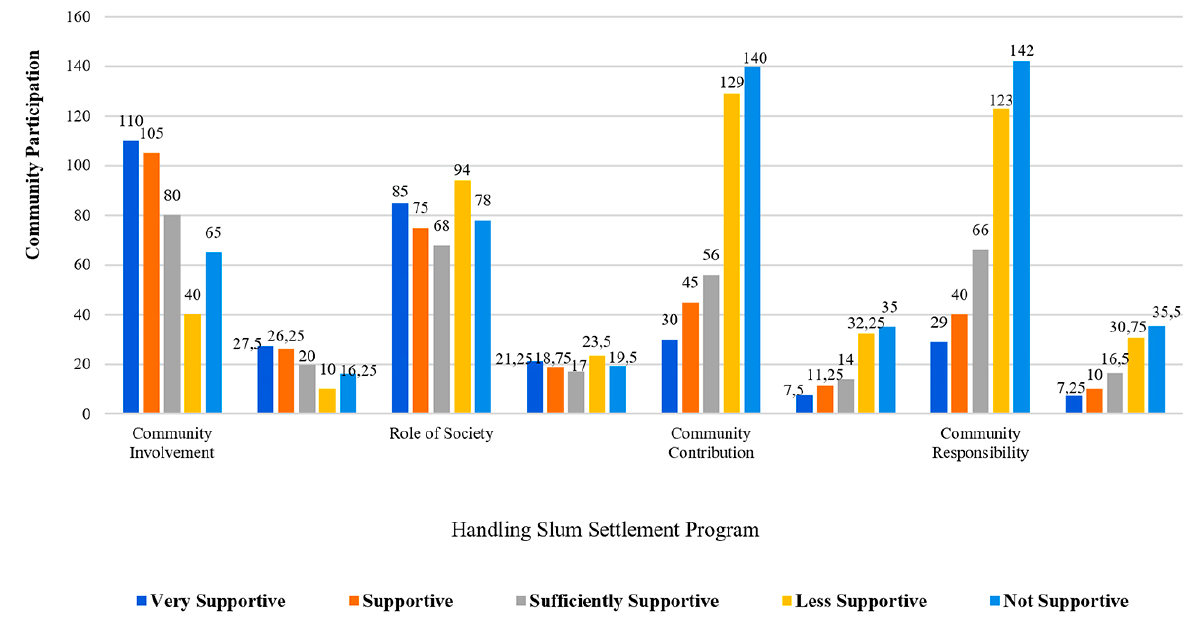
Figure 3. Community participation in the slum settlement